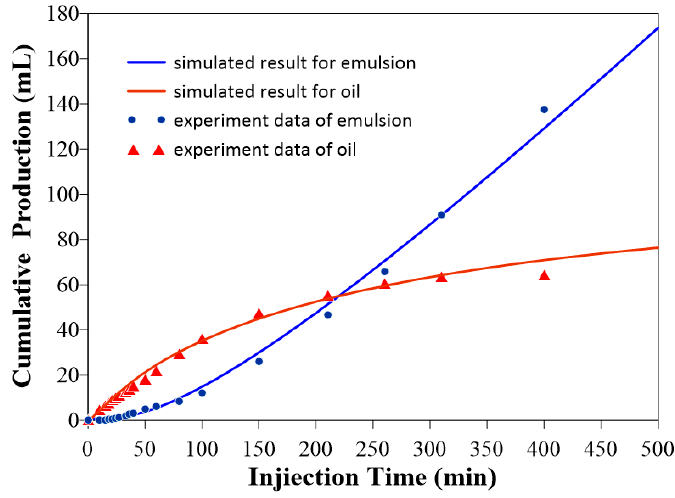
Figure 9. Comparison between simulation results and experiment data.